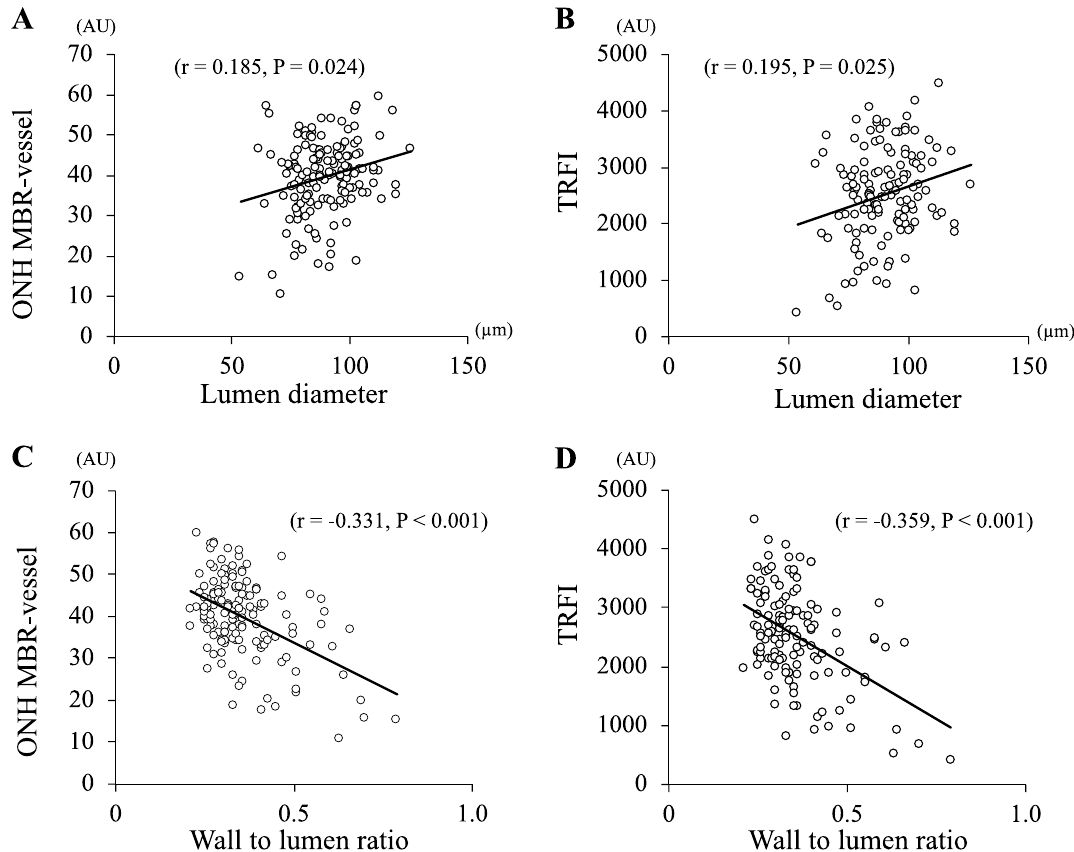
Figure 6. Correlation of morphological variables with blood flow parameters. The lumen diameter is significantly correlated with the MBR-vessel ( A ) and TRFI ( B ). The WLR is correlated with the MBR-vessel ( C ) and TRFI ( D ).